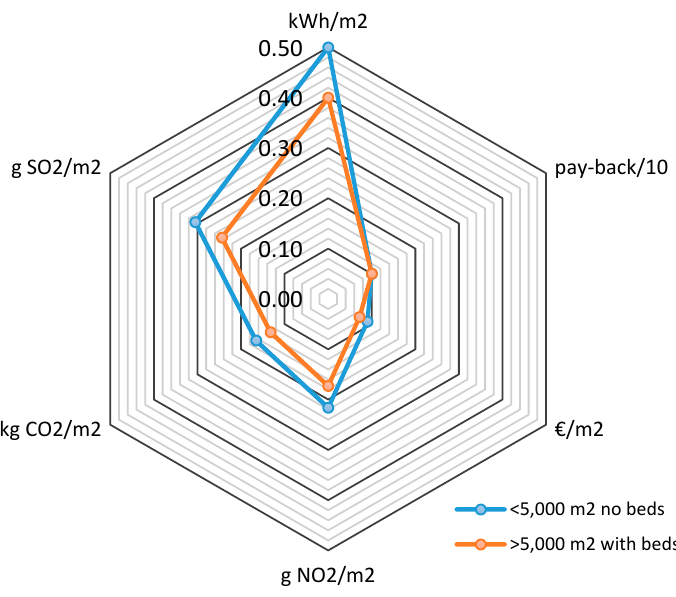
Figure 6. Potential of energy saving derived from maintenance management.